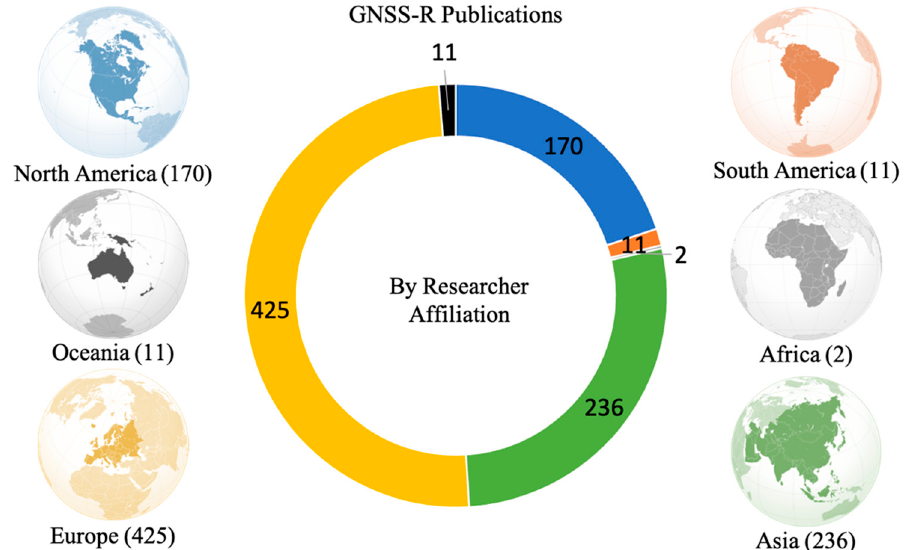
Figure 2. Distribution by researcher affiliation, including first author and co-authors, among all GNSS-R publications. The world maps describe the color code for the central chart. The number of publications is indicated for each colored part of the chart. Note that world maps have been adapted from Wikipedia images—licensed through CC BY-SA 4.0.